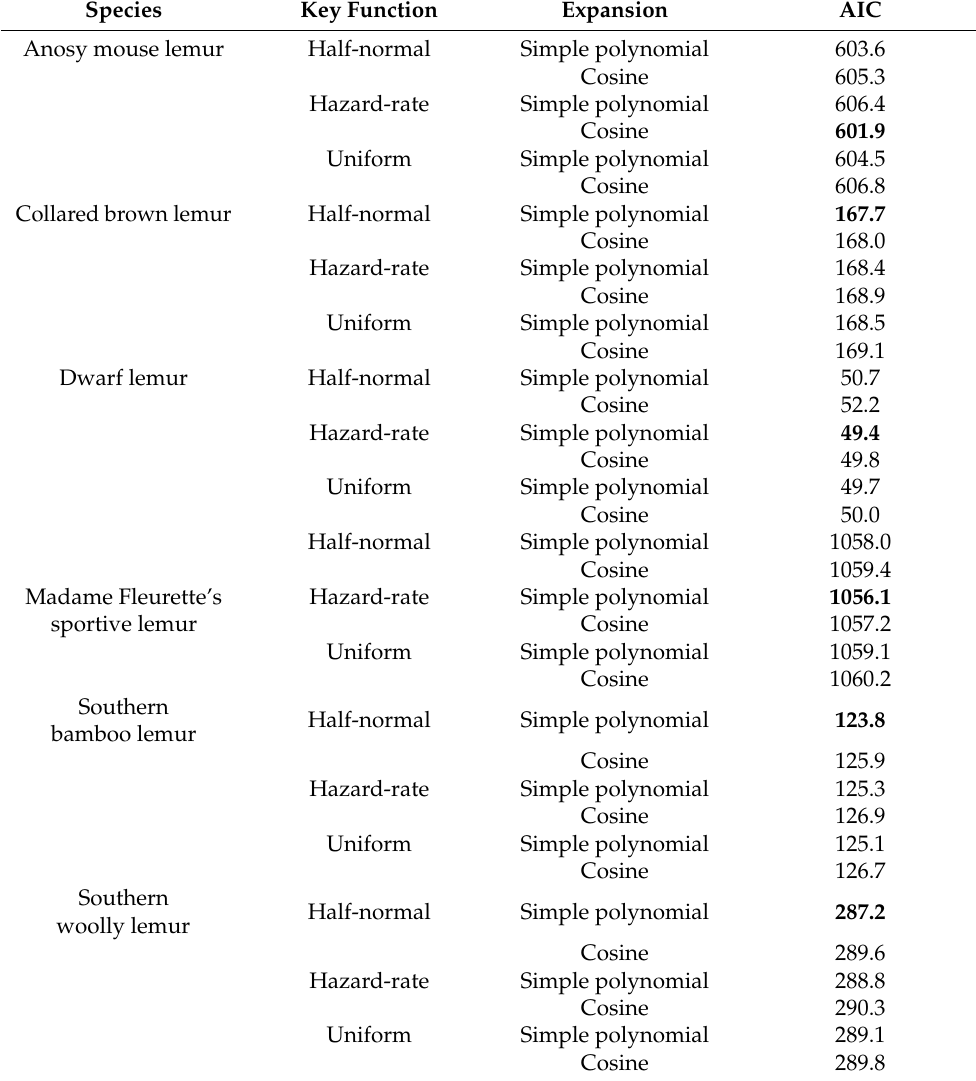
Table A1. List of model tested via the Multiple Covariate Distance Sampling method in Distance software and their AIC scores. In bold we highlight the selected model for each